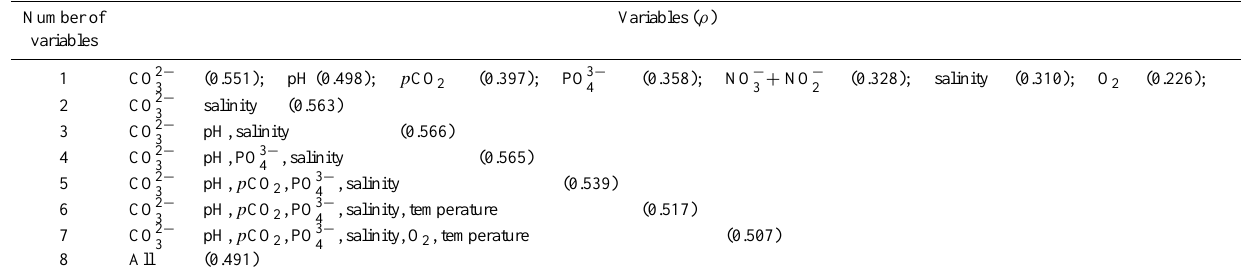
Table 3. Rho values ( ρ) for the best Spearman’s rank correlations for all possible combinations between the environmental parameters explaining patterns in heterococcolithophore assemblages. Description as in Table